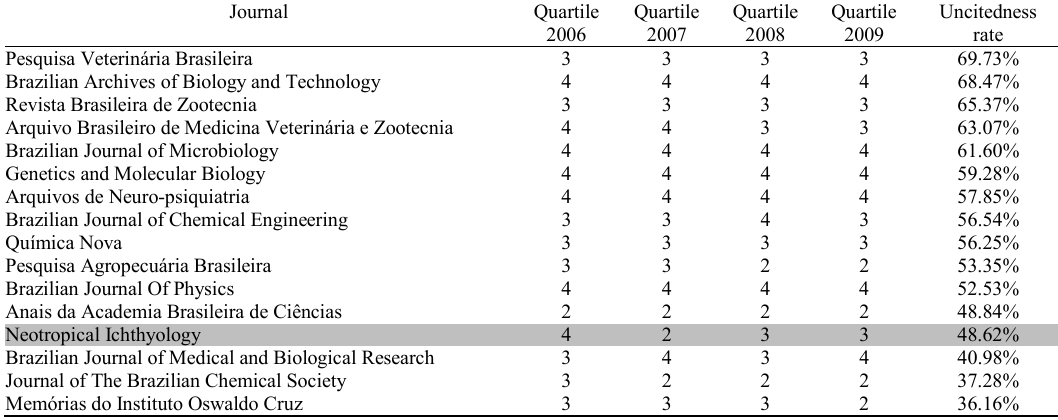
Table 7. Correlation between uncitedness rates and quartile ranking of the IF of journals in Sample 2.